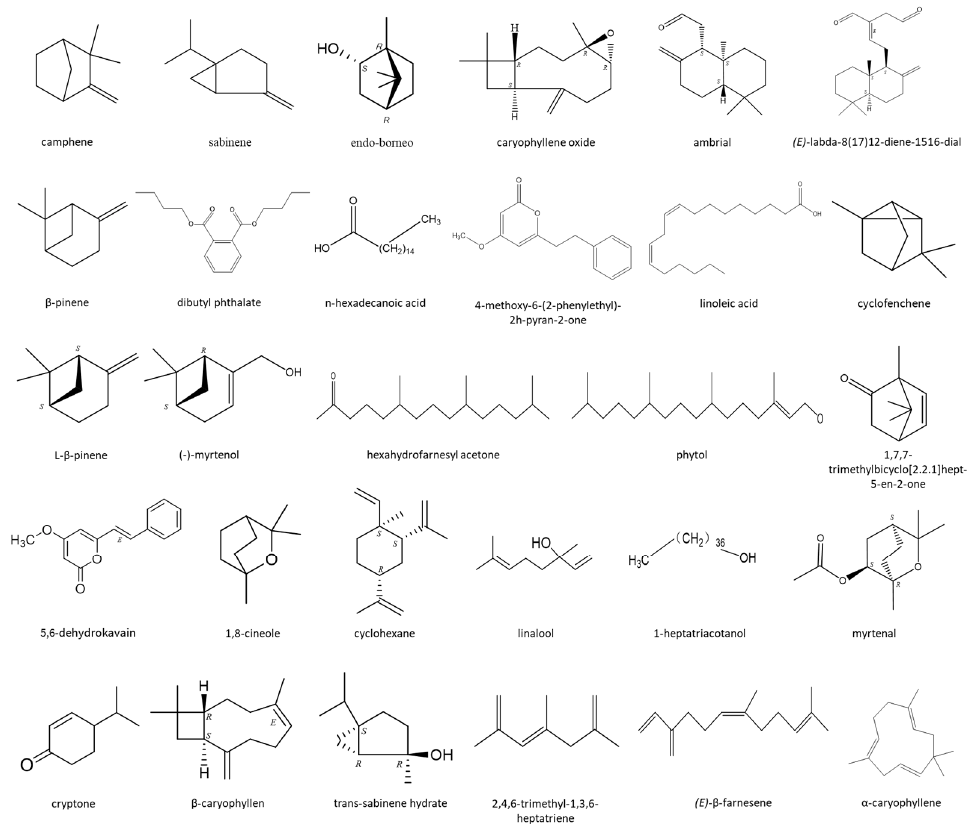
Figure 6. Structural formulae of the main volatiles from ten species of Zingiberaceae plants.